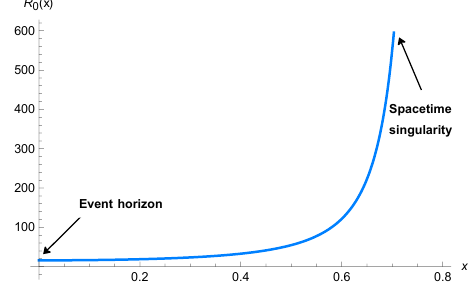
Figure 2 . The behavior of the scalar curvature R 0 , where λ = 4 and 0 ≤ x ≤ π